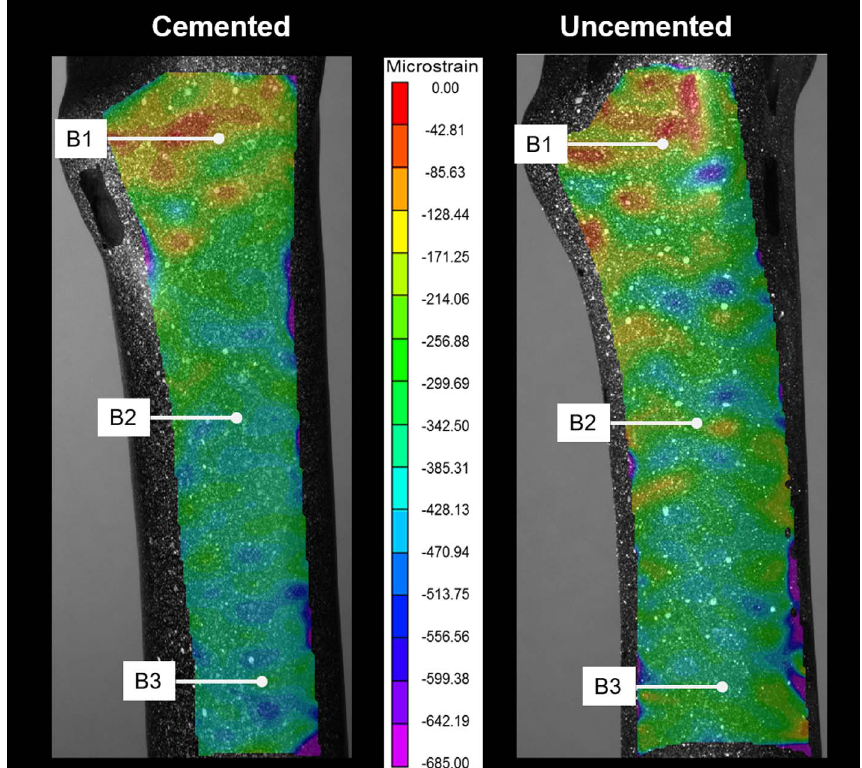
Figure 4. Comparison between the pattern of minimum principal strain across the medial side of the bone, between the uncemented and cemented group at 500 N axial